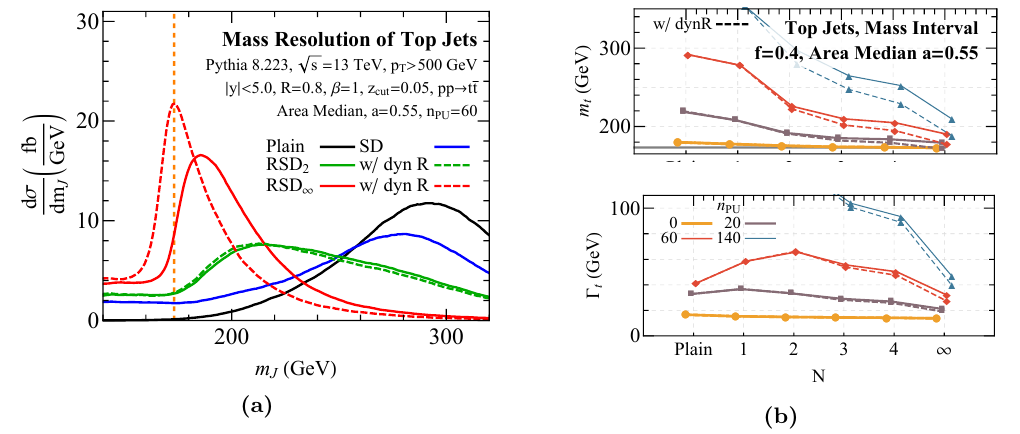
Figure 12. (a) Similar to (cid:12)gure 11a, but with 60 pileup vertices and using an area-median parameter of a = 0 : 55. Note the larger mass range shown and the inclusion of both (cid:12)xed- R 0 and dynamic- R 0 results. (b) Same as (cid:12)gure 11b but for the area-median method applied to RSD with dynamic R 0